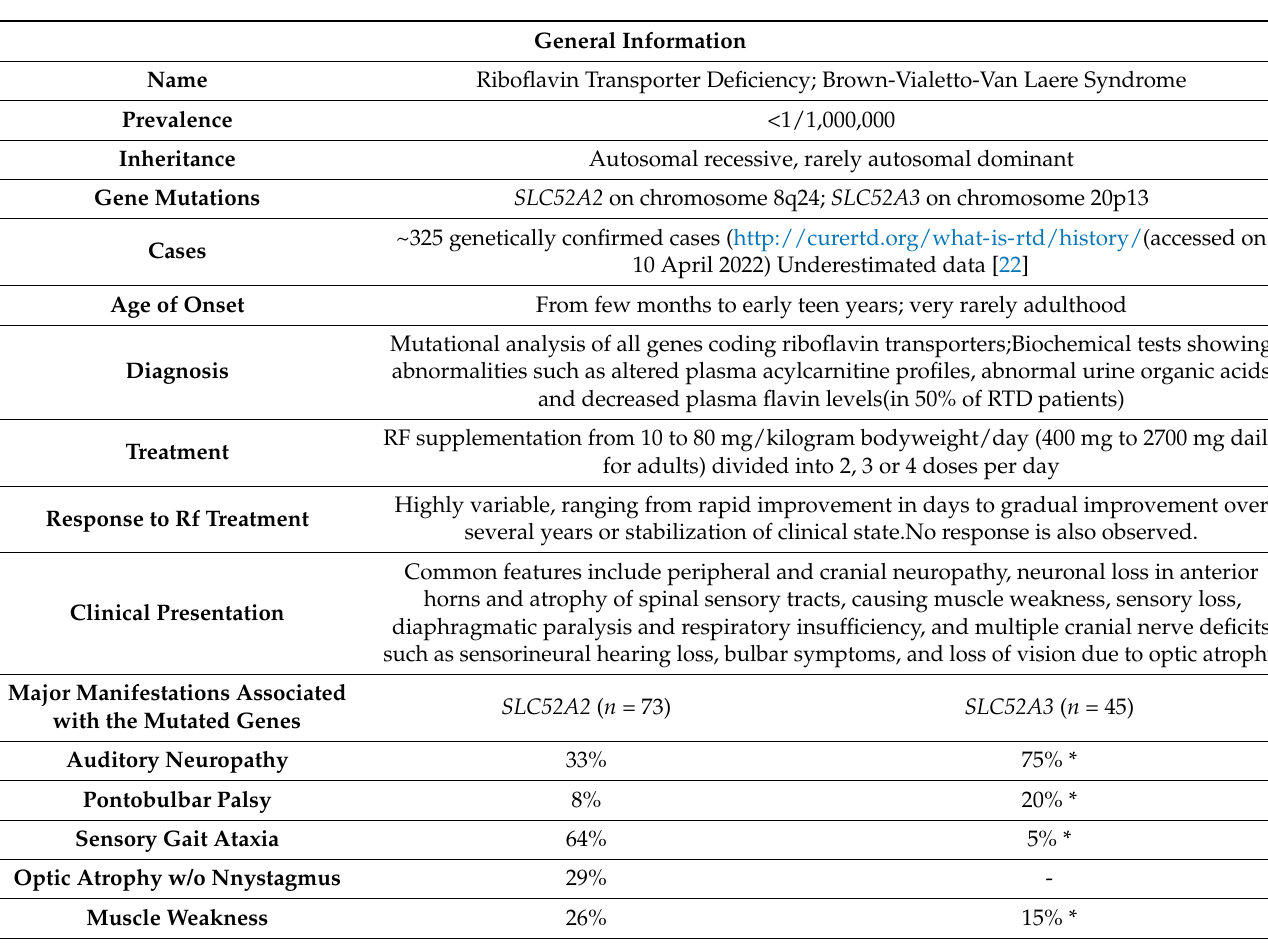
Table 1. Clinical features associated with